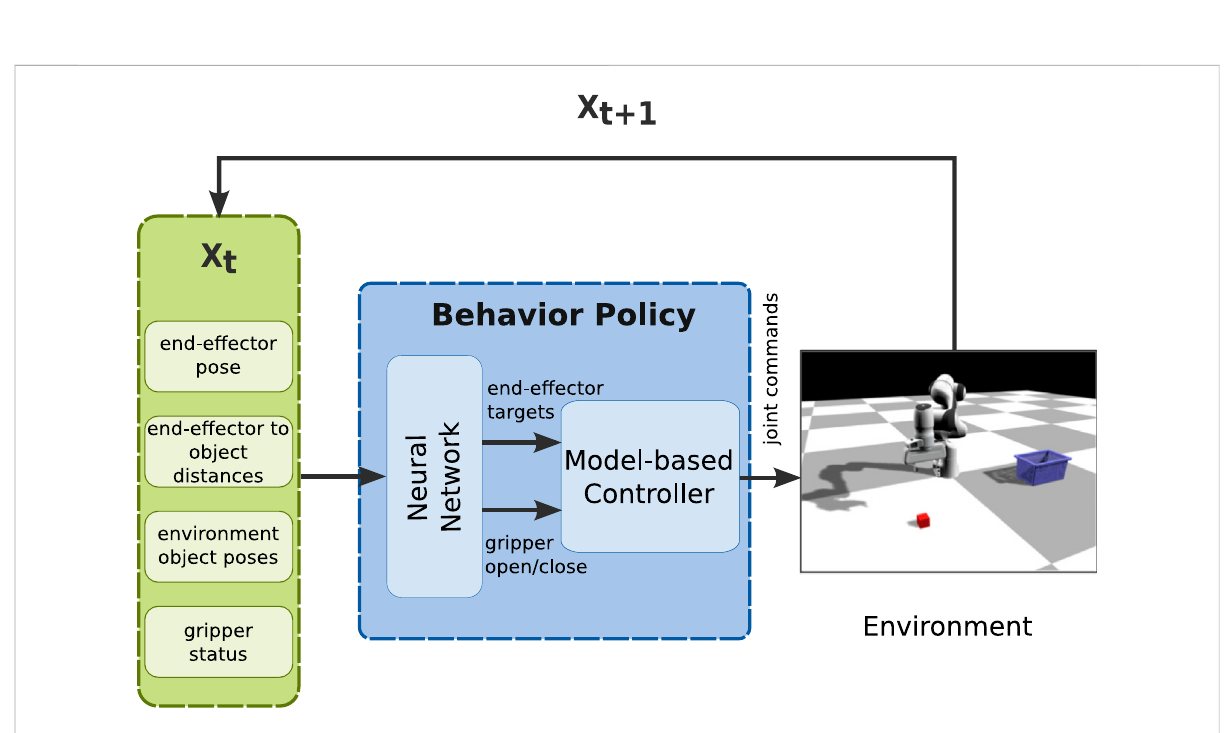
FIGURE 2 Overview of the proposed policy structure, where input includes environment-speci fi c information (end-effector pose, end-effector to object distance, environmentobject poses, gripper status) and outputsthe desired trajectory(joint commands), using a neural network and a model-based controller as the Behavior Policy Learning